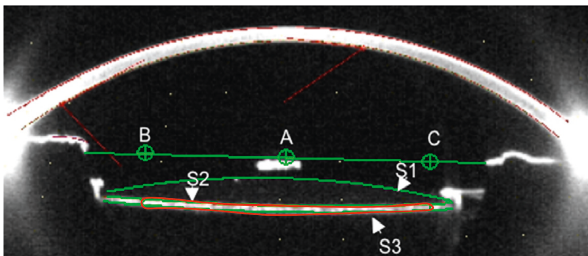
Figure 1: Illustration graph of the PCO evaluation method with the Pentacam (the figure was acquired at the horizontal meridian). Measurement of PCO characteristics in one cross-sectional image. S: surface; S1: anterior surface of IOL; S2: posterior surface of IOL; S3: posterior capsule. Point A is the centre of the horizontal line, which is the centre of the pupil, and the distance between points B and C is 5mm of the central optic region. The PCO area is located between S2 and S3, which is indicated with a red line.